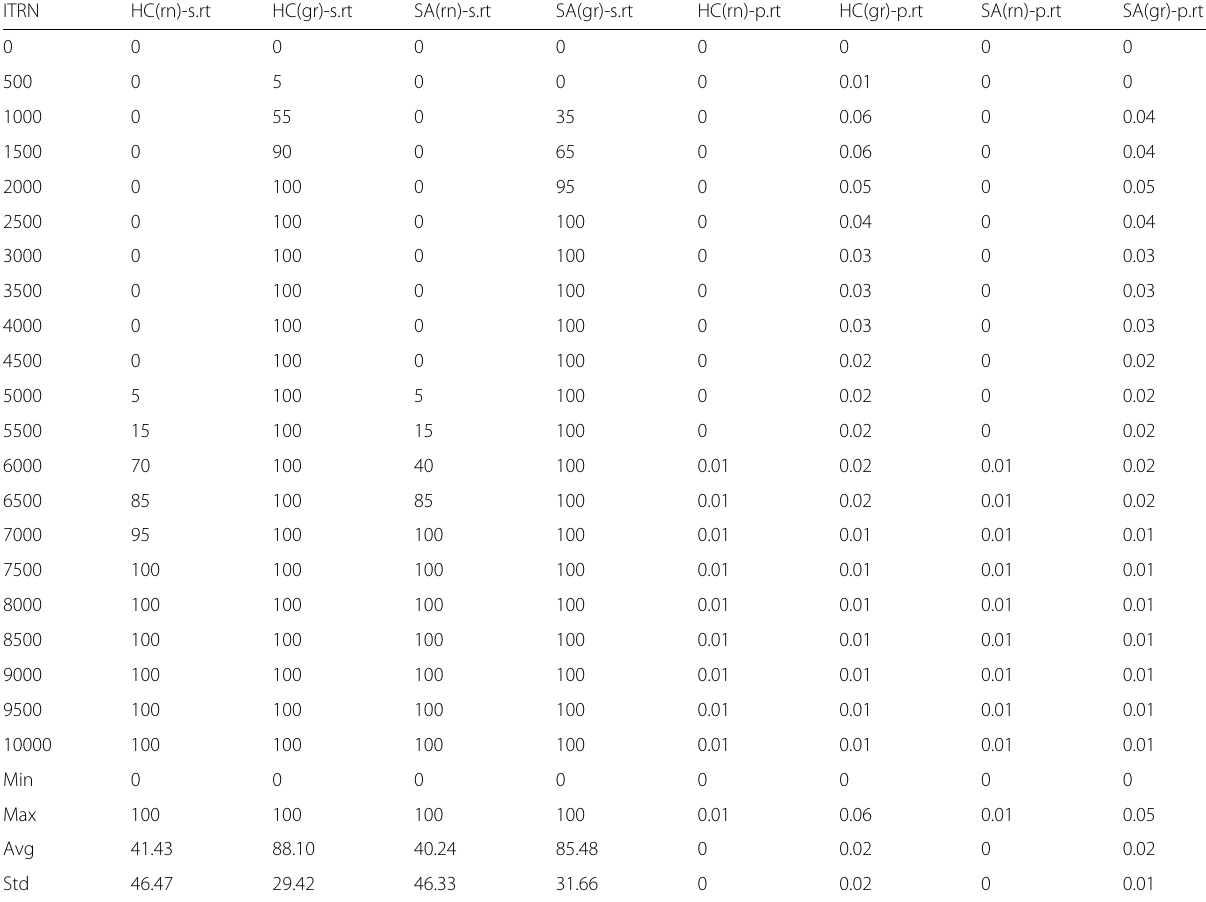
Table 9 Success Rate(s.rt) and Performance Rate (p.rt) based on Target Solution (C(500-20-4))